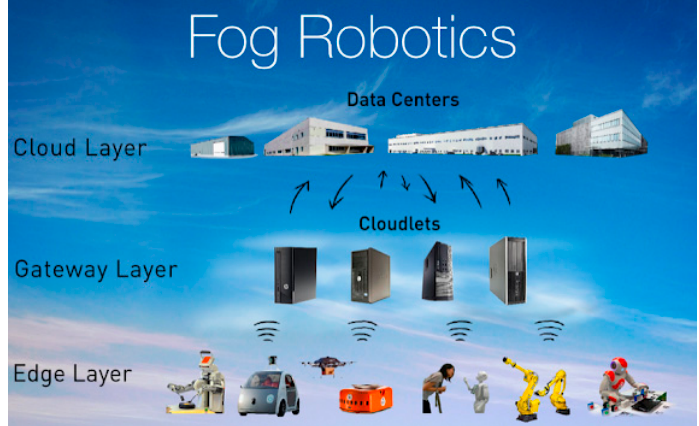
Figure 1. Fog robotics schematic [18].